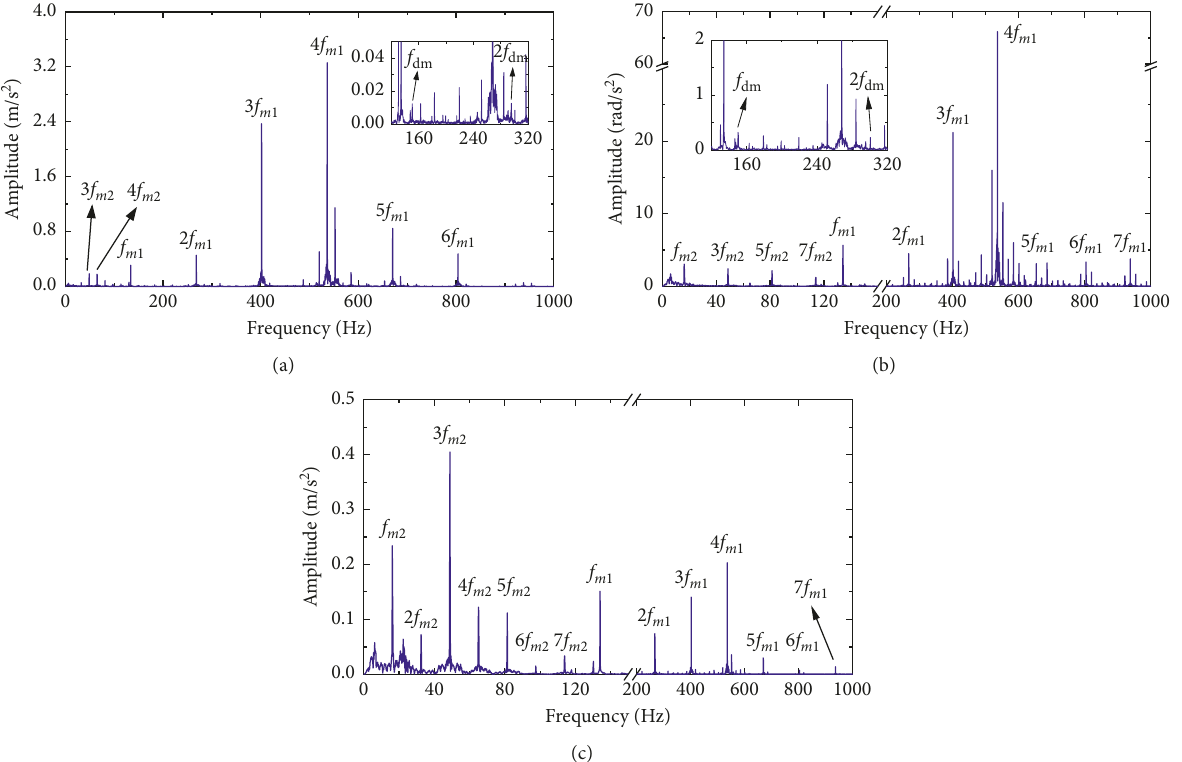
Figure 15: Frequency-domain curves of acceleration. (a) Reducer shell in direction y . (b) 2nd drive gear in rotational direction. (c) Drum in direction y .